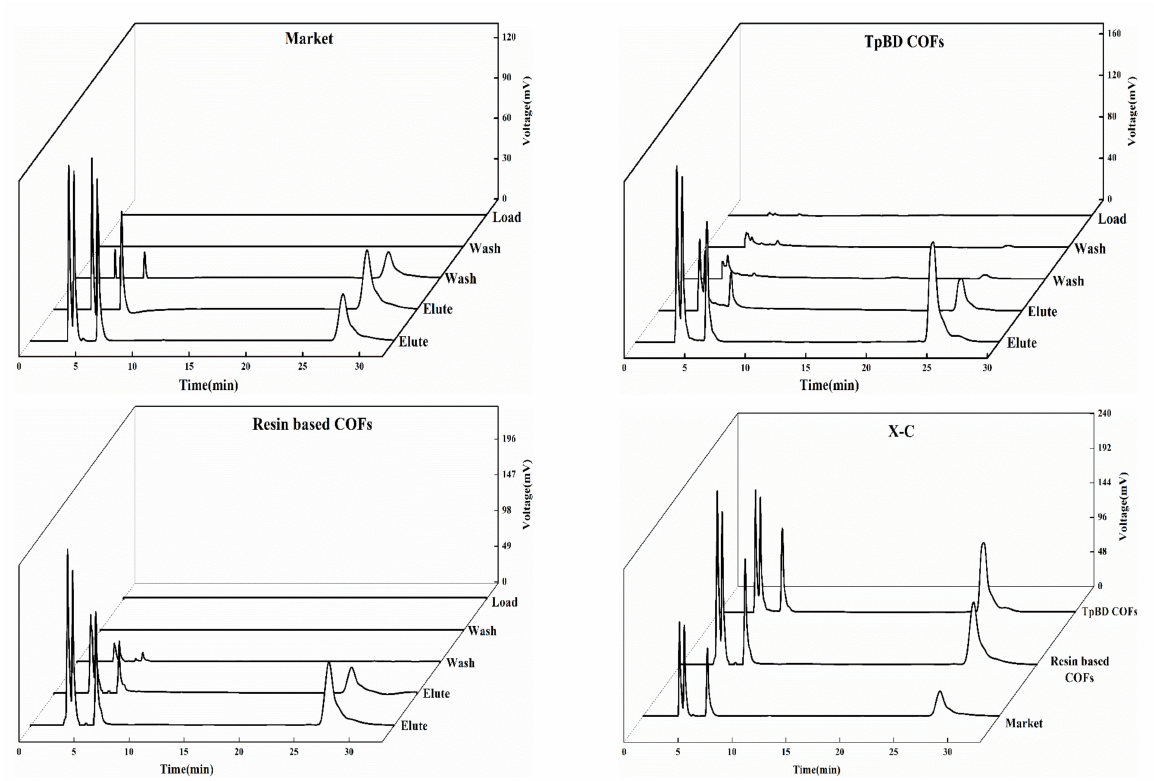
Figure 8. Outflow curves using the X-C method.